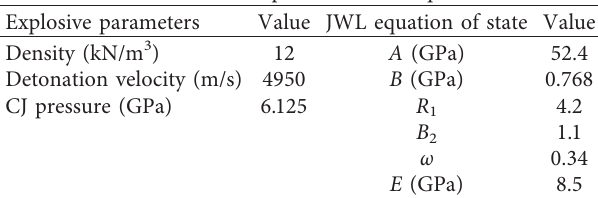
Figure 3: Calculation model of empty-hole directional Table 2: Parameters of explosive and its equation of state.